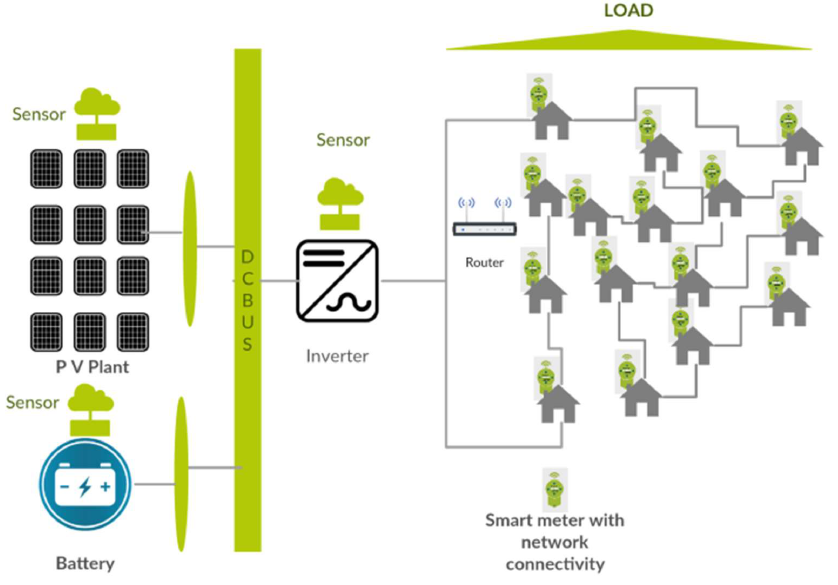
Figure 1. Microgrid electrical configuration overview.